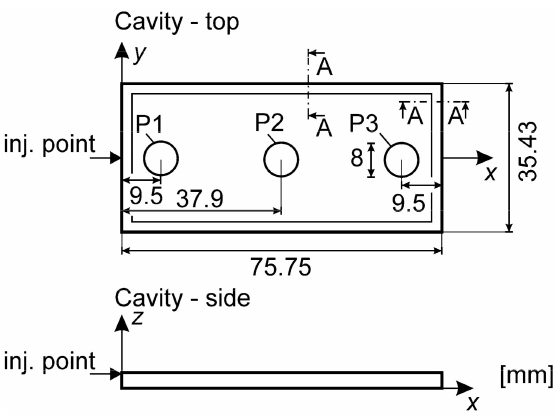
Figure 1. Mold cavity